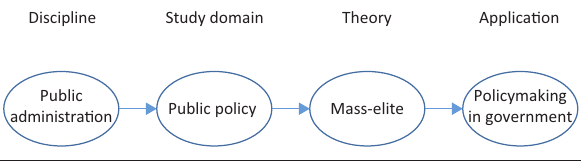
FIGURE 6: Theory application in